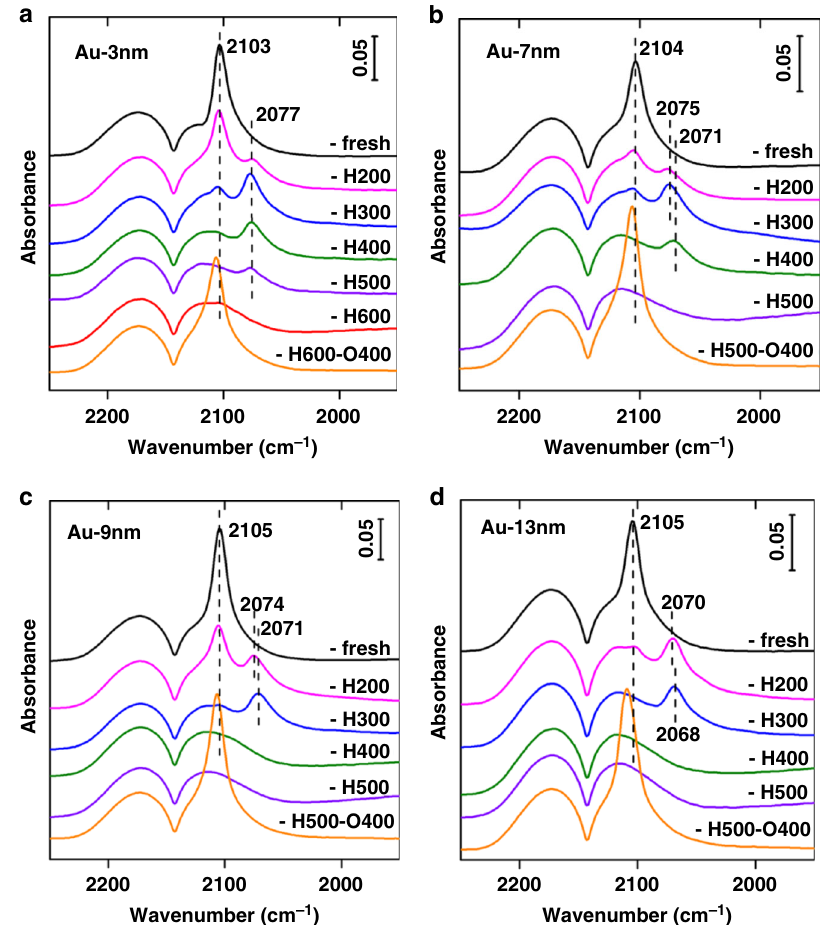
Fig. 1 In situ DRIFT spectra of CO adsorption over Au/TiO 2 with different particle size. a Au-3 nm, b Au-7 nm, c Au-9 nm, and d Au-13 nm. The notation of -fresh represents the as-synthesized samples, the notation of -HX represent samples reduced by 10 vol% H 2 /He under different temperatures, and the notation of -HX-O400 represent samples reoxidized at 400 °C after